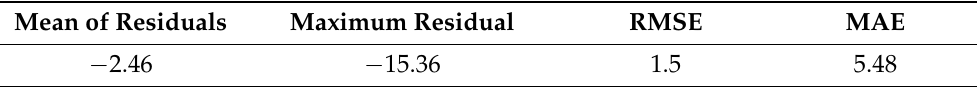
Table 4. The results of high frequency evaluation (µm) for the proposed method. Mean of Residuals